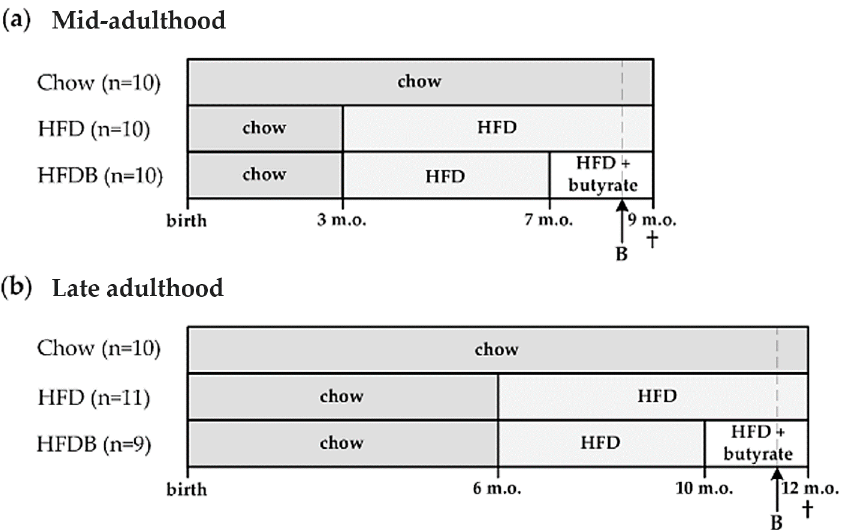
Figure 1. Schematic overview of the study design. ( a ) Mid-adulthood, exposure of the high-fat died HFD started at 3 m.o. in the HFD and HFDB groups. At 7 months of age, the butyrate intervention (HFD supplemented with 5% w / w butyrate) started in the HFDB group; ( b ) Late adulthood, exposure to the HFD started at 6 months of age in the HFD and HFDB groups, and a butyrate intervention initiated at 10 months of age in the HFDB group. Body weight (individual) and food intake (cage level) were monitored weekly. Blood samples were taken after five hours of fasting. At 9 m.o. and 12 m.o., mice were sacrificed and both liver and adipose tissues were harvested. These tissues were subsequently processed for immunohistochemical staining. B = blood sample collection; HFD = high-fat diet; HFDB = high fat diet enriched with butyrate; m.o. = months old.